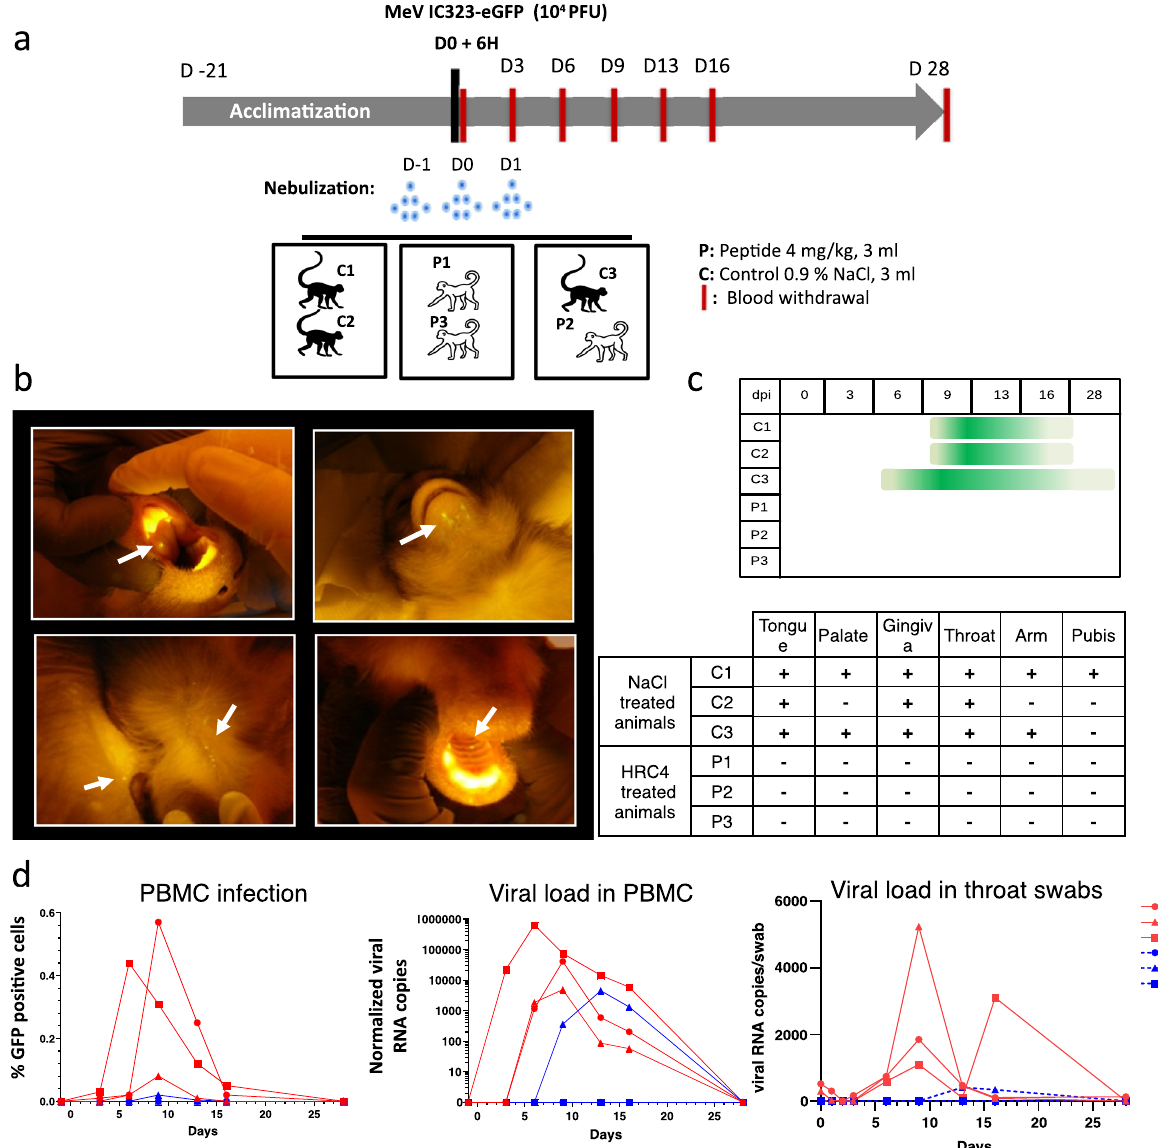
Fig. 6 | HRC4 nebulization protects monkeys from clinical manifestation of MeV infection. a Experimental design: cynomolgus monkeys (3 animals/group) were either nebulized with 3ml of NaCl 0.9% (control group, C) or with 3ml HRC4 peptide 4mg/ml (experimental group, P), 24h and 6h before and 24h after intra- tracheal infection with 10 4 PFU MeV IC323-eGFP. Blood samples were taken every 3 days for the fi rst 16 days and fl uorescence of the skin and mucosa tested at that timepoints. b MacroscopicmanifestationofMeVinfection,typical fl uorescentrash